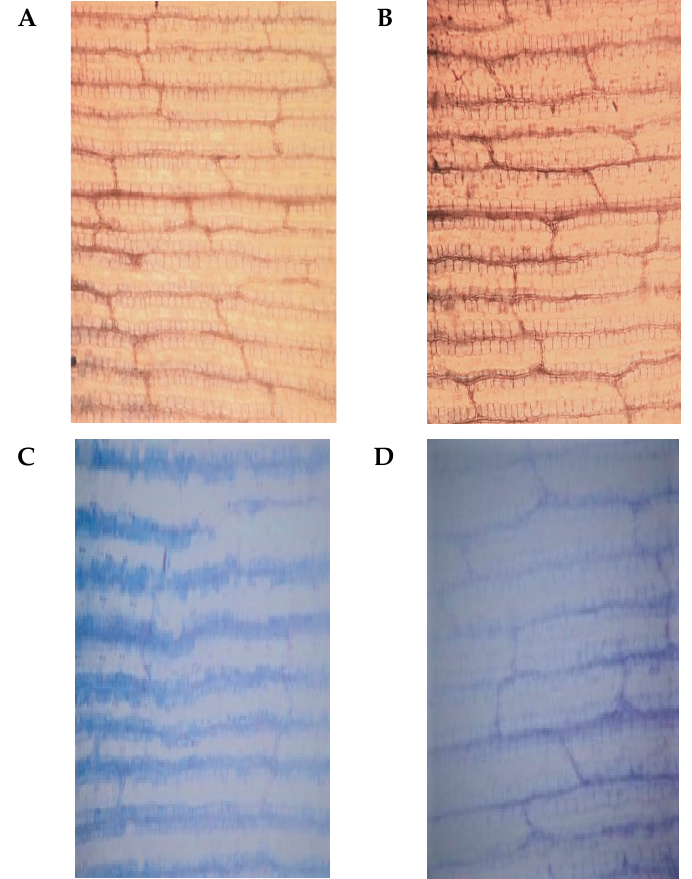
Figure 2. Results of trypan blue staining of leaves. ( A ) Non-stressed sensitive inbred line MO17, ( B ) non-stressed tolerant line YE8112, ( C ) drought-stressed MO17, and ( D ) drought stressed YE8112, seven days post drought exposure. Scale bars = 200 µm.